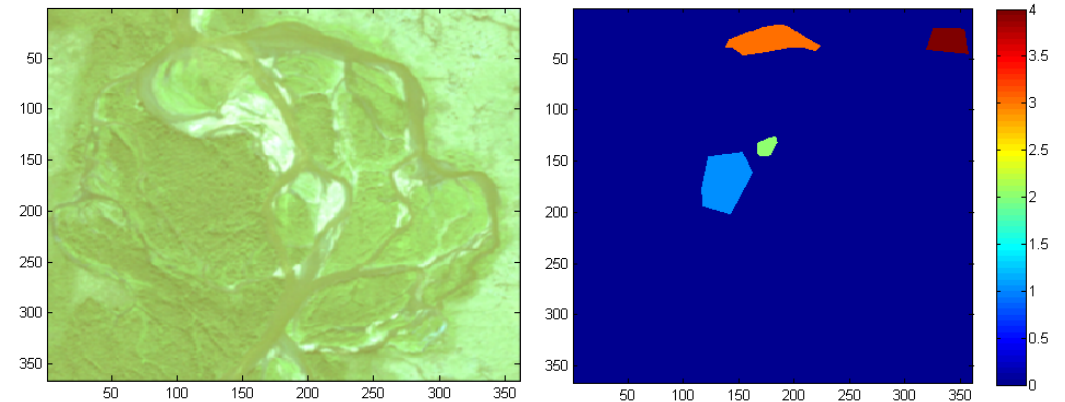
Figure 3. On the left, is an image of a flood plain on the Kwethluk River, Alaska. On the right, the polygons denote the location of the training data set, taken from the image on the left; 1 denotes conifer trees, 2 denotes cobble, 3 denotes water, and 4 denotes deciduous trees.